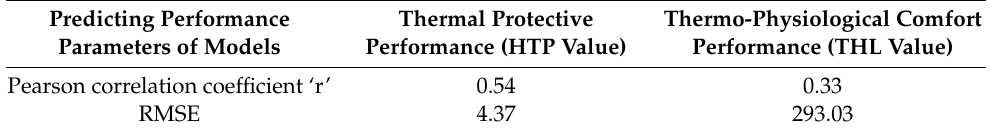
Table 3. The Pearson correlation coefficient and RMSE of the developed ANN